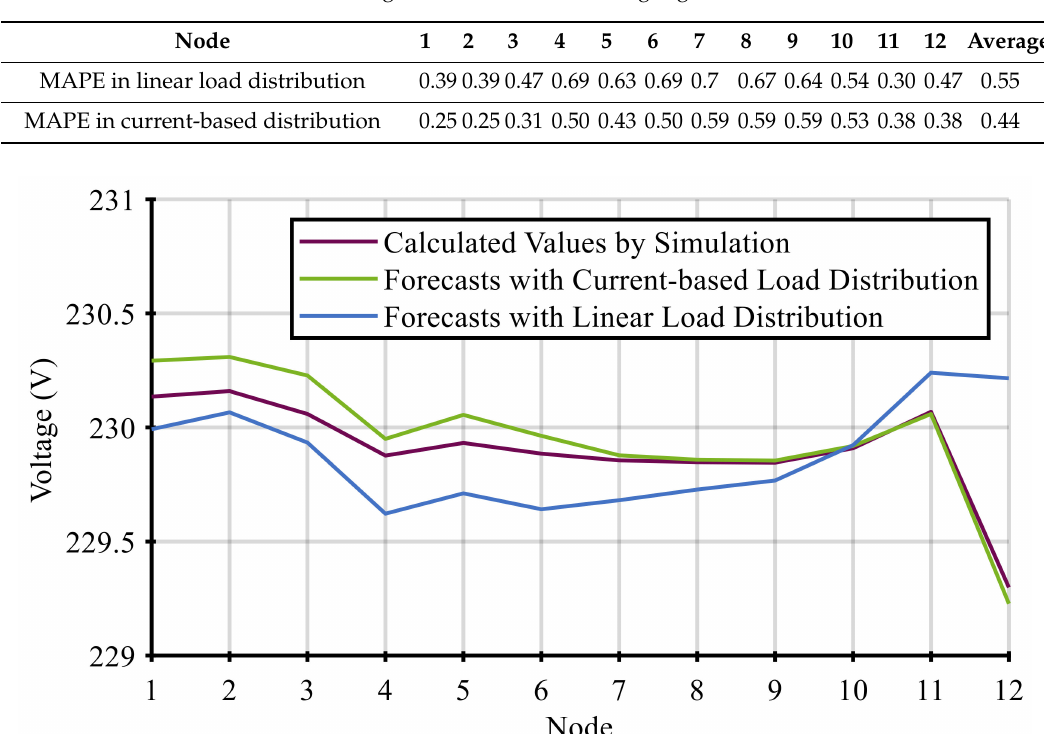
Table 2. Voltage forecast errors at the highlighted nodes.